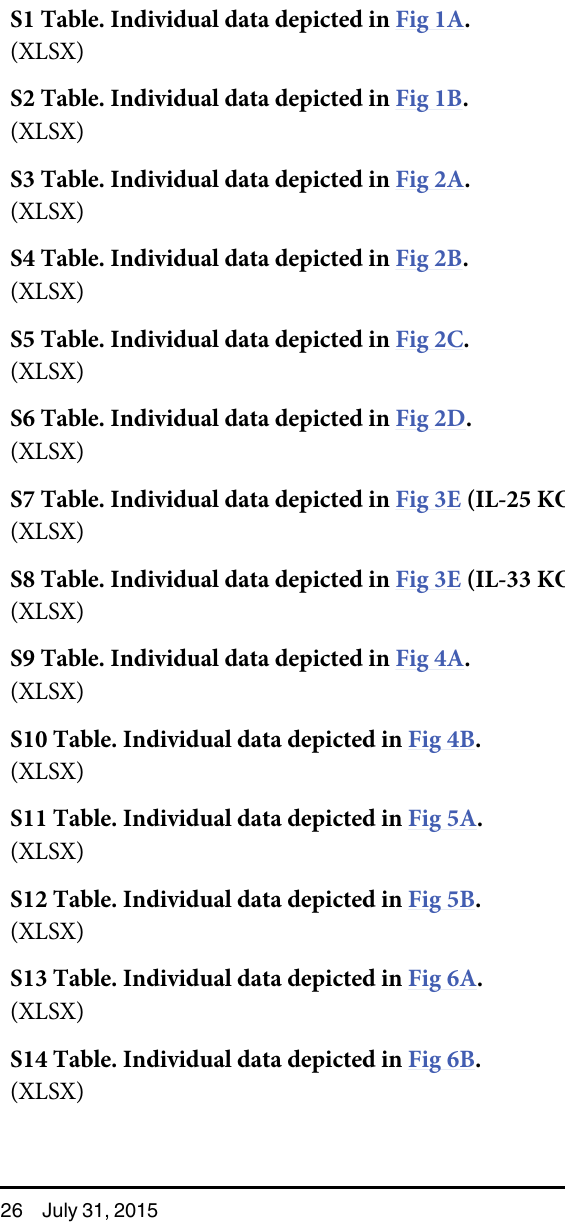
S1 Table. Individual data depicted in Fig 1A. S2 Table. Individual data depicted in Fig 1B. S3 Table. Individual data depicted in Fig 2A. S4 Table. Individual data depicted in Fig 2B. S5 Table. Individual data depicted in Fig 2C. S6 Table. Individual data depicted in Fig 2D. S7 Table. Individual data depicted in Fig 3E (IL-25 KO). S8 Table. Individual data depicted in Fig 3E (IL-33 KO). S9 Table. Individual data depicted in Fig 4A. S10 Table. Individual data depicted in Fig 4B. S11 Table. Individual data depicted in Fig 5A. S12 Table. Individual data depicted in Fig 5B. S13 Table. Individual data depicted in Fig 6A. S14 Table. Individual data depicted in Fig